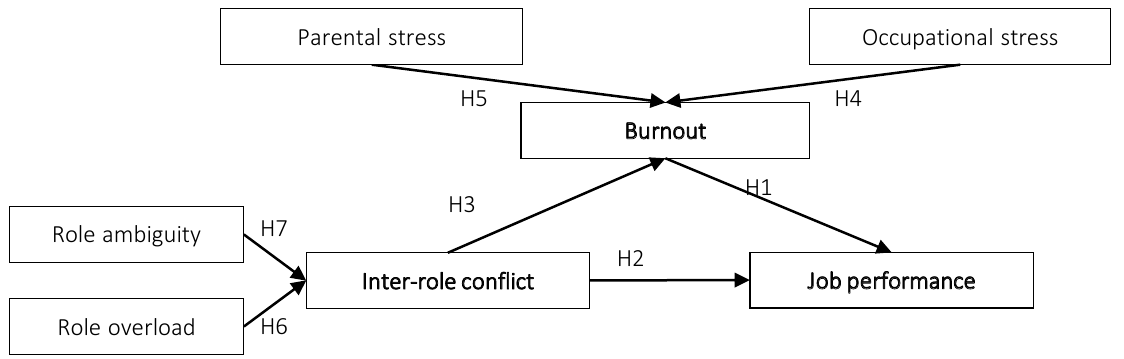
Figure 1. Research